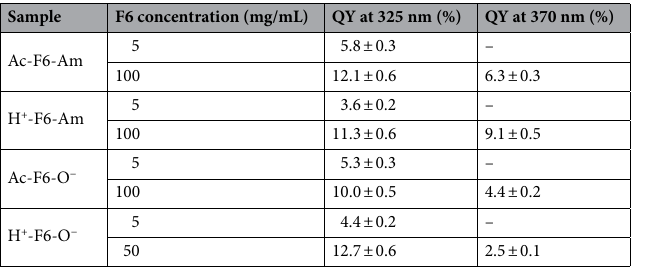
Table 2. Summary of the measured values of PLQY of all F6 samples at the different concentrations.